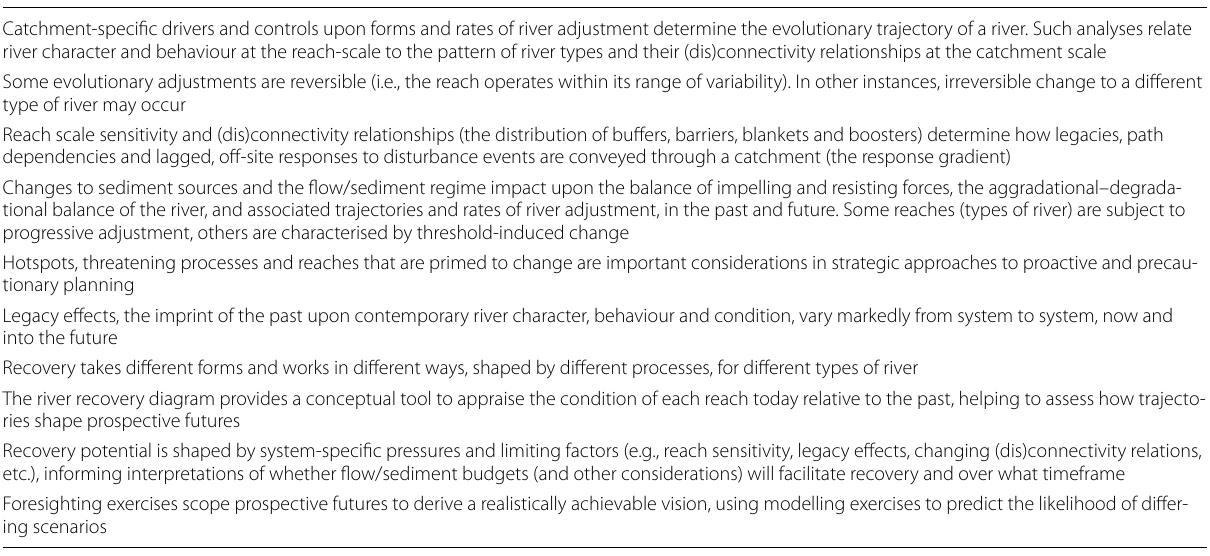
Table 6 Geomorphic principles that underpin interpretations of evolutionary trajectory to determine what is realistically achievable ( Truth 4